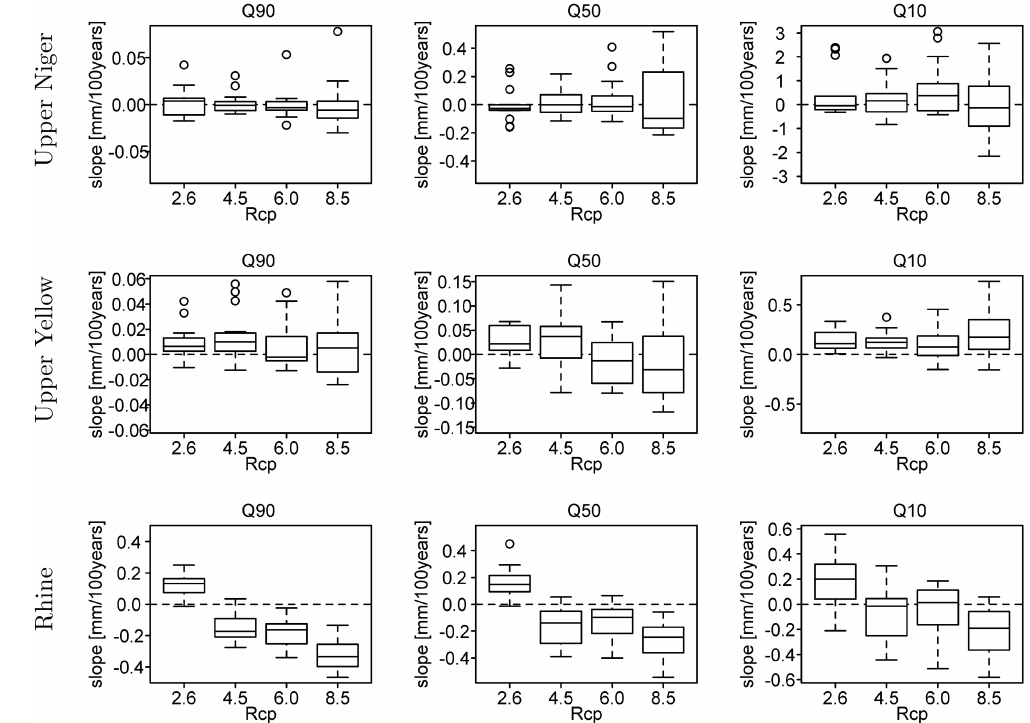
Figure 8. Boxplots for the slopes of the linear trend for the Upper Niger, Upper Yellow and Rhine in three runoff quantiles grouped by RCPs. Outliers as circles. Outlier = distance to median (center line of box) exceeding 2.5 times the interquartile range (length of the